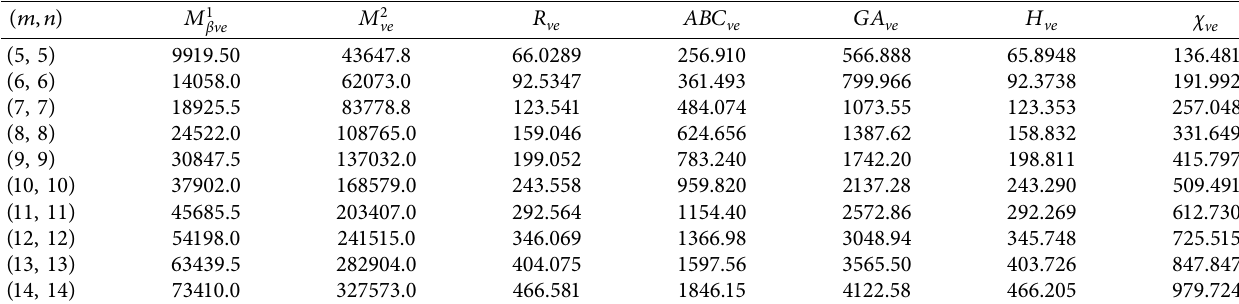
, M 2 ve , H ve , R ve , χ ve , ABC ve , GA ve for Y -junction graph Y m ( n, n ) . β ve